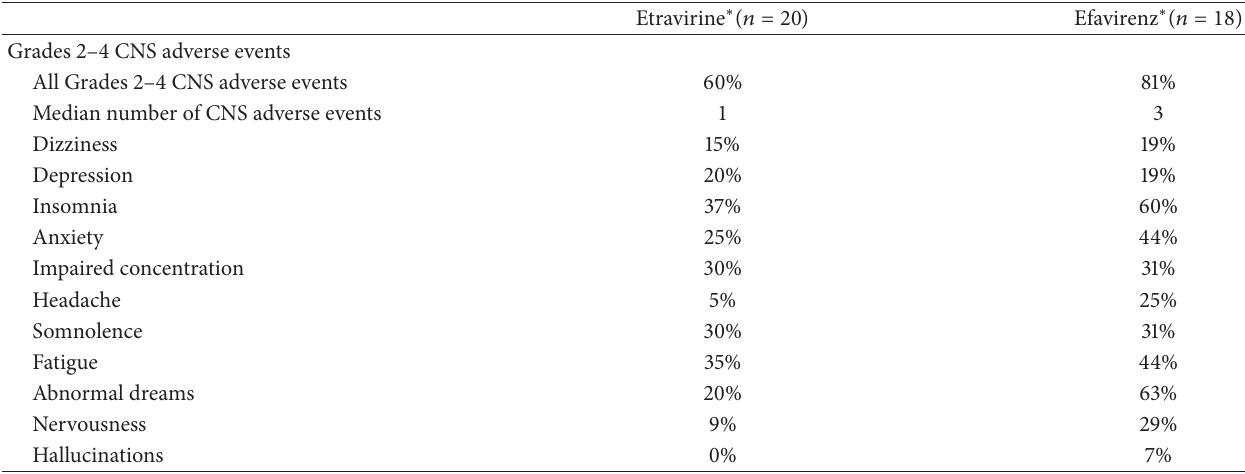
Table 4: UK SSAT029 trial: changes in CNS adverse events by treatment arm, to Week 12.